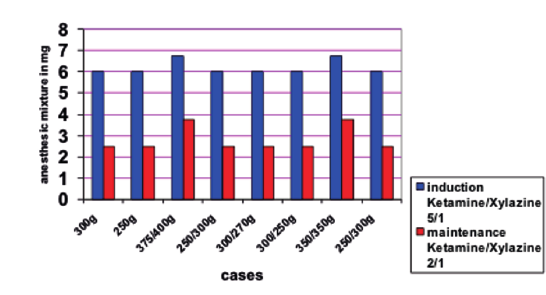
Table 2. The anesthetics doses reletated to the weight of the rat